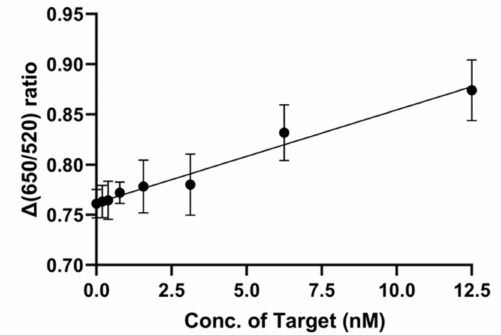
Figure 6. The detection limit of the AuNP-NP7 aptanano sensor system. LOD using the o ffi cial formula from the International Union of Pure and Applied Chemistry (IUPAC) (LOD = 3 × SD /